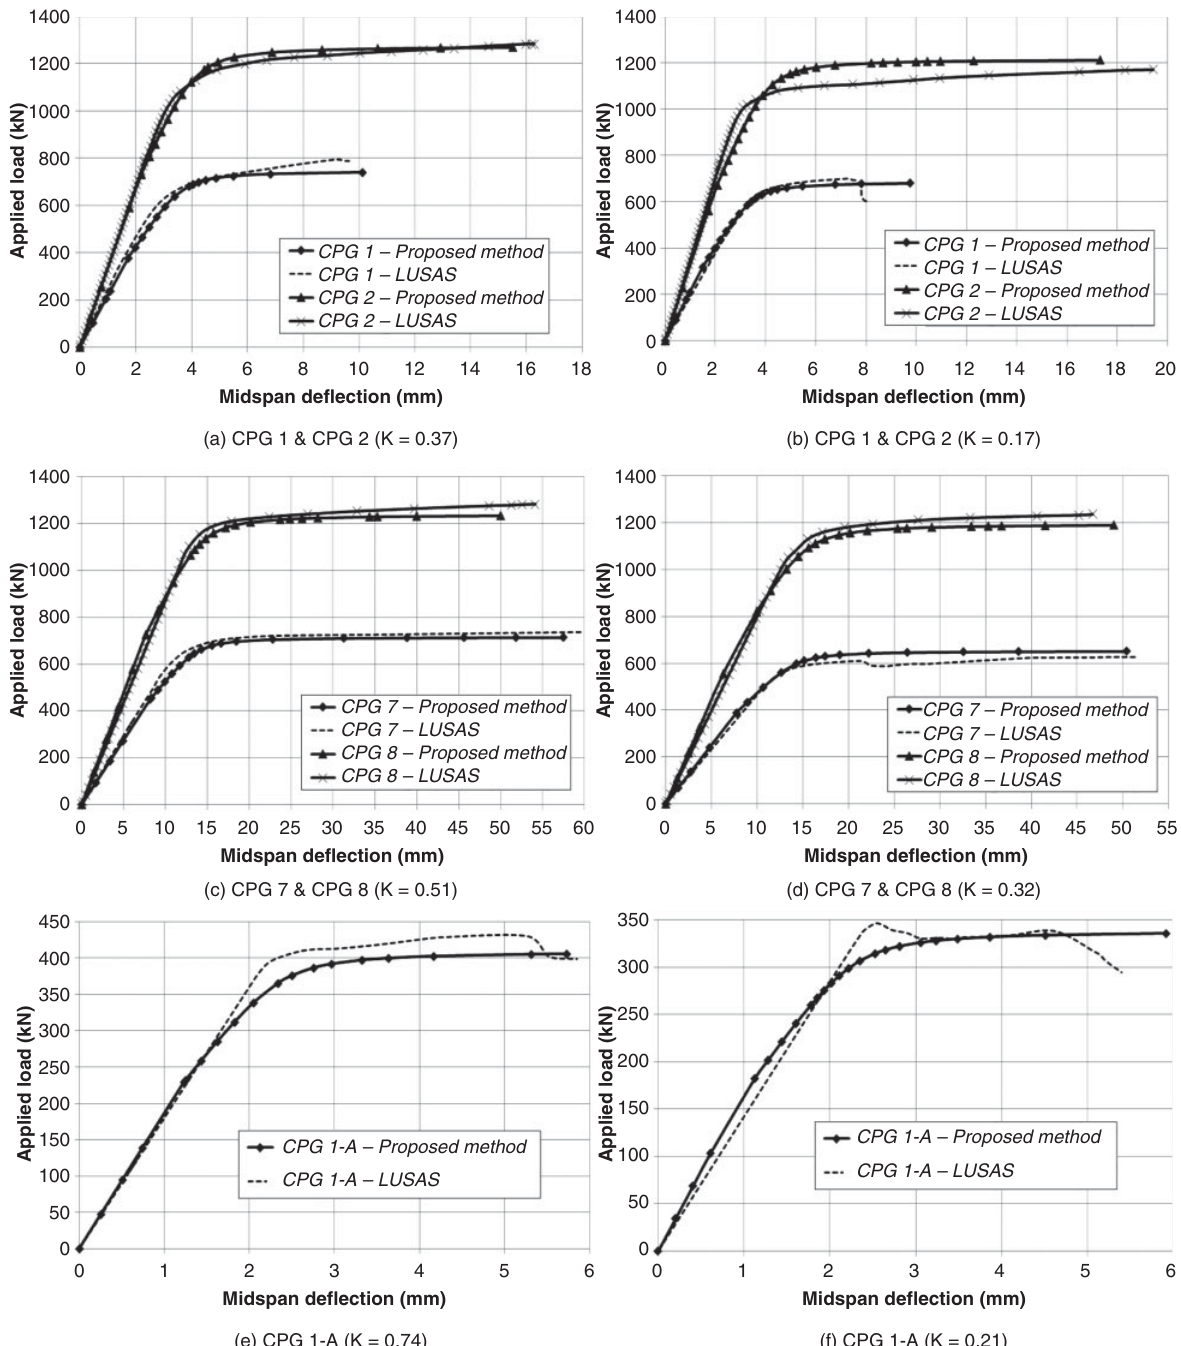
Fig. 6. Comparisons of load-de fl ection plots – typical behaviour: (a) CPG 1 & CPG 2 ( K = 0.37); (b) CPG 1 & CPG 2 ( K = 0.17); (c) CPG 7 & CPG 8 ( K = 0.51); (d) CPG 7 & CPG 8 ( K = 0.32); (e) CPG 1-A ( K = 0.74); (f) CPG 1-A ( K =